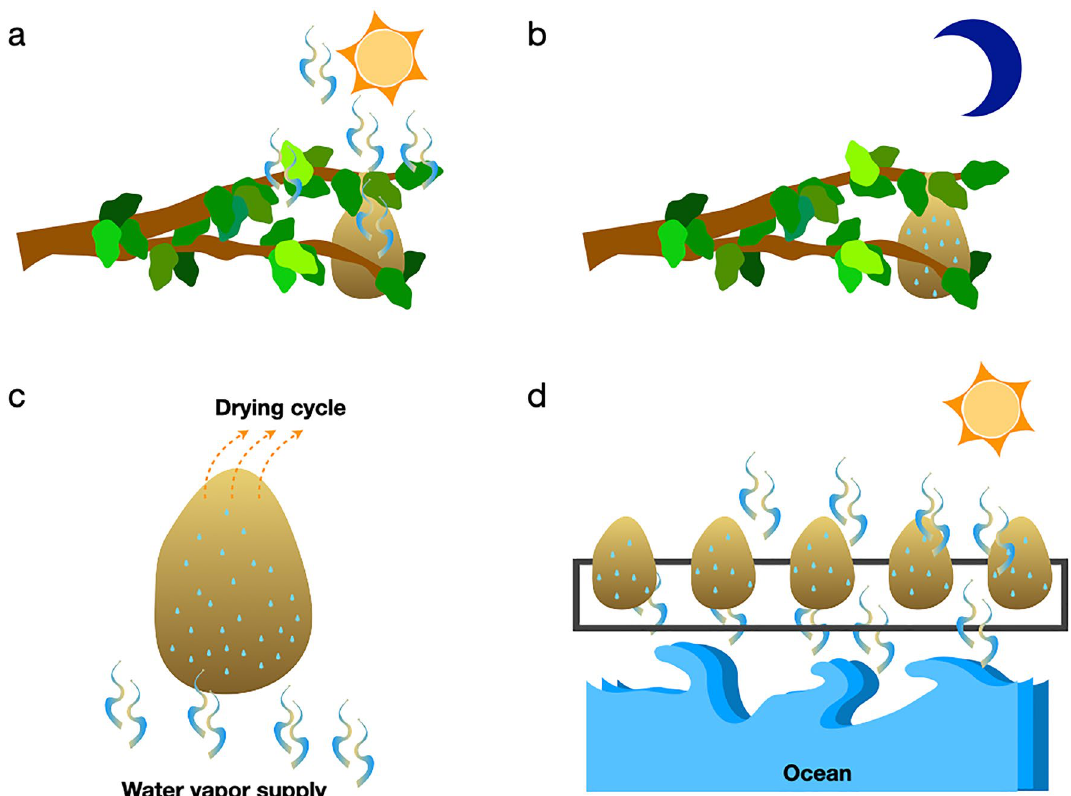
Figure 10. Cocoon ecology. ( a ) During day time, solar radiation causes evapotranspiration from nature. The humidity gets trapped in the silk cocoon’s microstructured channels due to its proximity to the surrounding vegetation. ( b ) During the nighttime, the trapped moisture condenses inside the silk cocoon pores as the temperature falls. ( c ) The simultaneous application of dry air and water vapor causes a water gradient across the cocoon. ( d ) Cocoon’s natural ability to trap moisture and convert it into green electricity makes it a suitable material for AWG